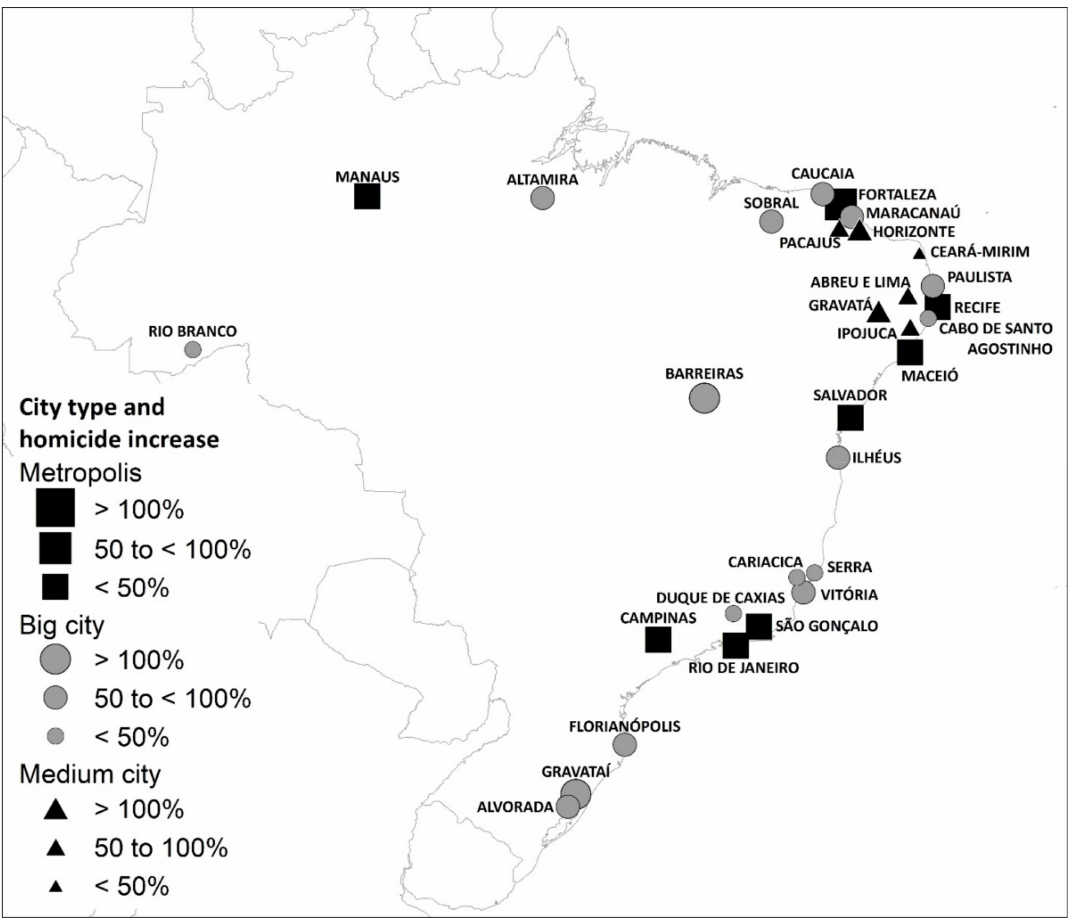
Figure 2. Cities in Brazil (and their respective homicide increase) that accounted for the equivalent national increase in homicides between 2016 and